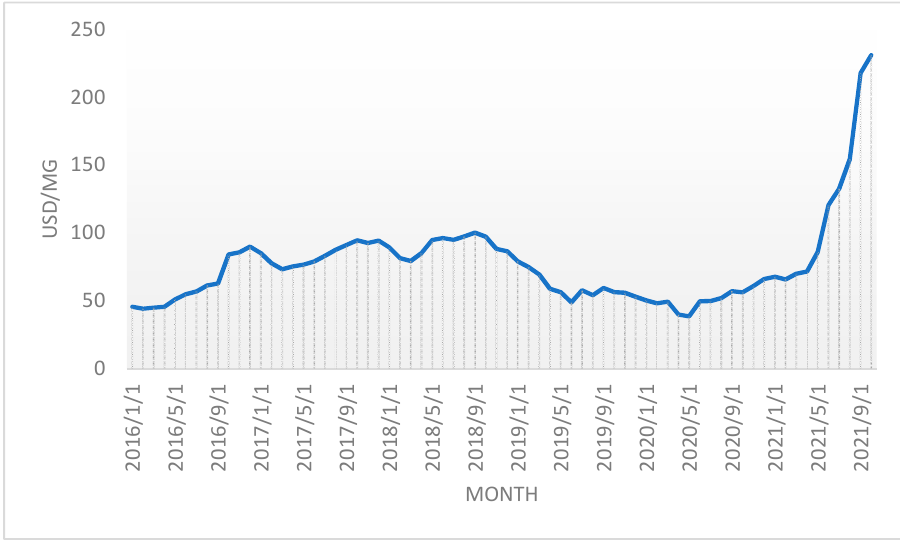
Figure 3. Coal Price (API2) CIF ARA (ARGUS-McCloskey) Futures—(MTFc1) [33]. The Polish coal market, on the other hand, is significantly lagged and does not react dynamically to changes in fuel prices on foreign markets. This is caused by long-term fuel contracts concluded by coal companies with their strategic customers. Therefore, the demand for domestic coal is growing mainly due to domestic power plants and heating plants, which purchase Polish fuel before winter at currently favourable prices (Figure 4).